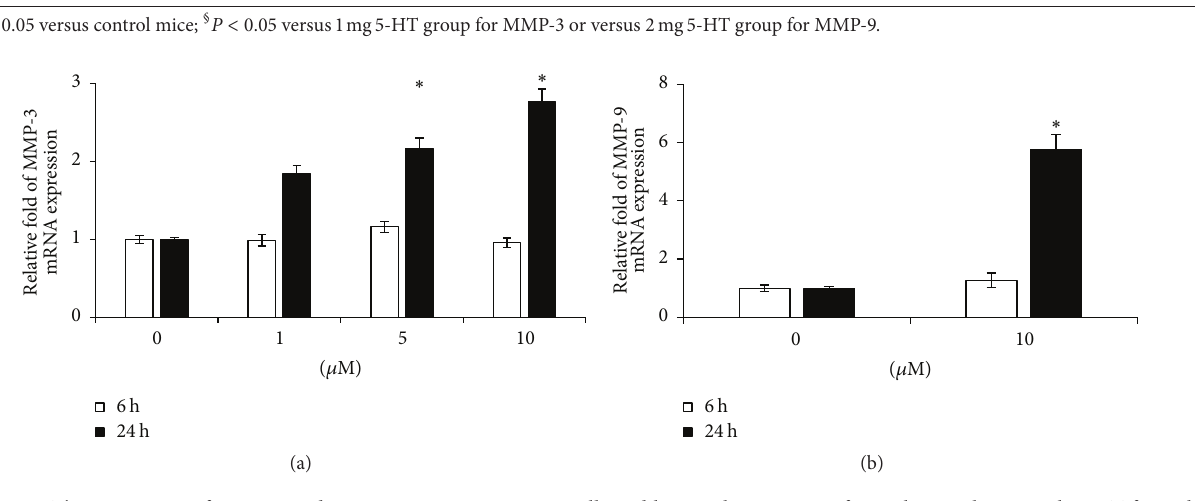
Figure 5: The expression of MMP-3 and MMP-9 mRNA in Caco-2 cells and human leucocytes. After 24 h stimulation with 5-HT for 24 h, MMP-3 mRNA expression in Caco-2 cells was significantly increased at the concentration of 5 and 10 𝜇 M (a). The expression of MMP-9 mRNA was up to 6-fold increase compared to the leucocytes without 5-TH stimulation (b). The data represent 4 experiments. ∗ 𝑃 < 0.05 versus cells without treatment with